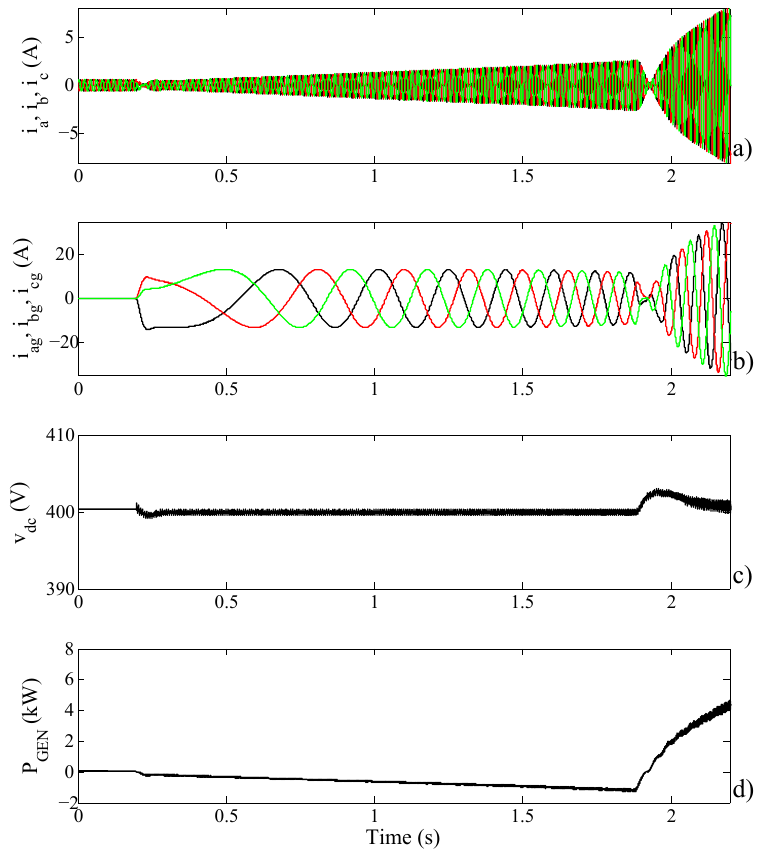
Figure 6. ( a) Grid-side currents; ( b ) Generator-side currents; ( c ) DC-link voltage; ( d ) Generator power